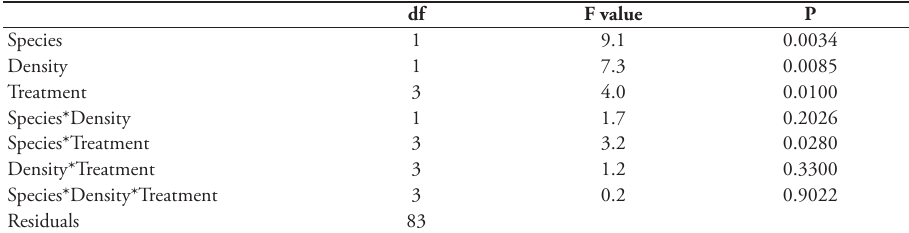
Table 2. Results of ANCOVA test assessing effect of Species, Density, and Food Treatment on detection time from the olfaction